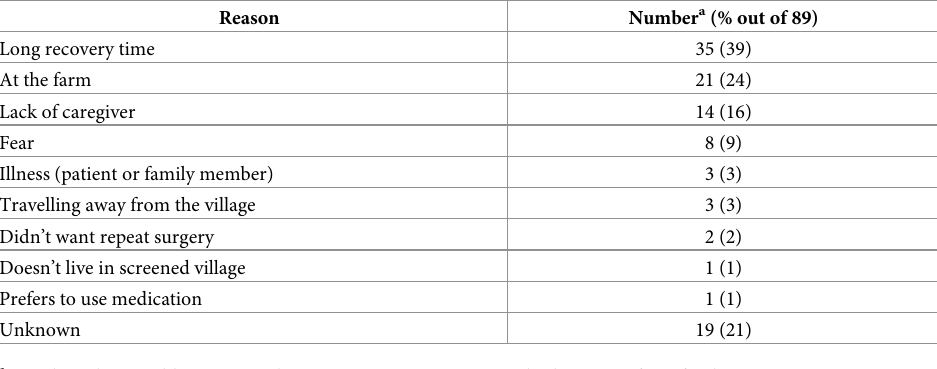
Table 1. Day-of-Surgery reasons for refusal reported by community health workers.